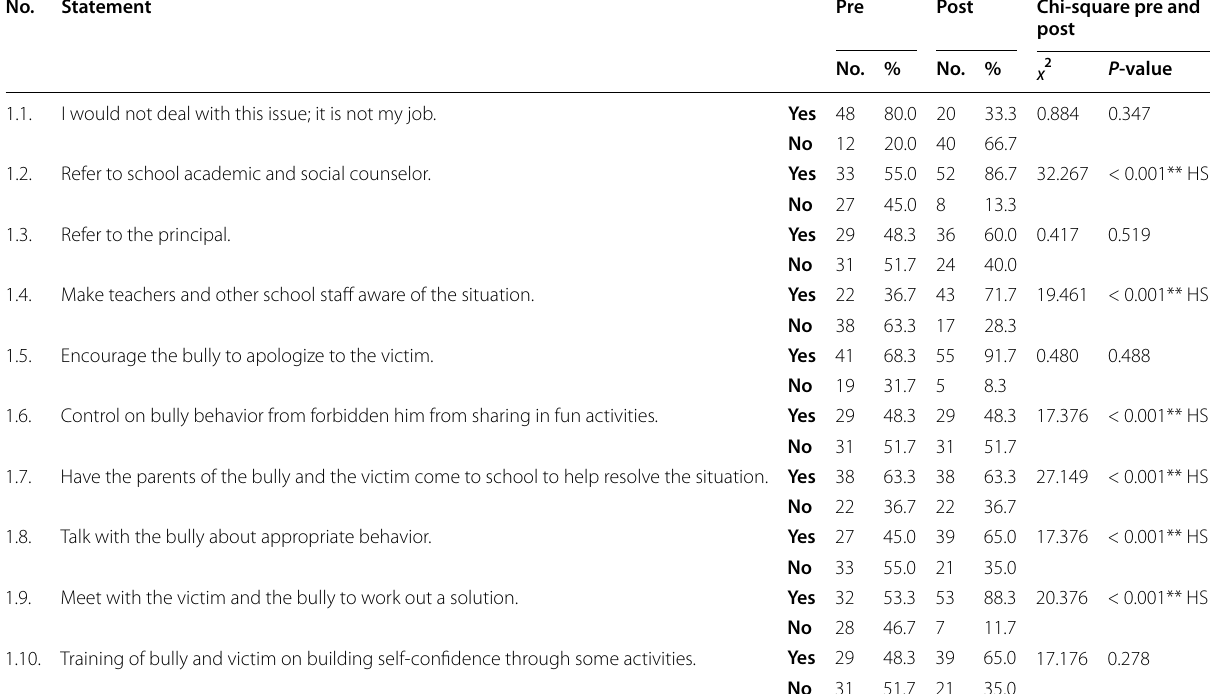
Table 2 Distribution of the studied subjects according to their intervention/dealing with a student who was a bully or victim pre and post a psychoeducational intervention ( n 60) =